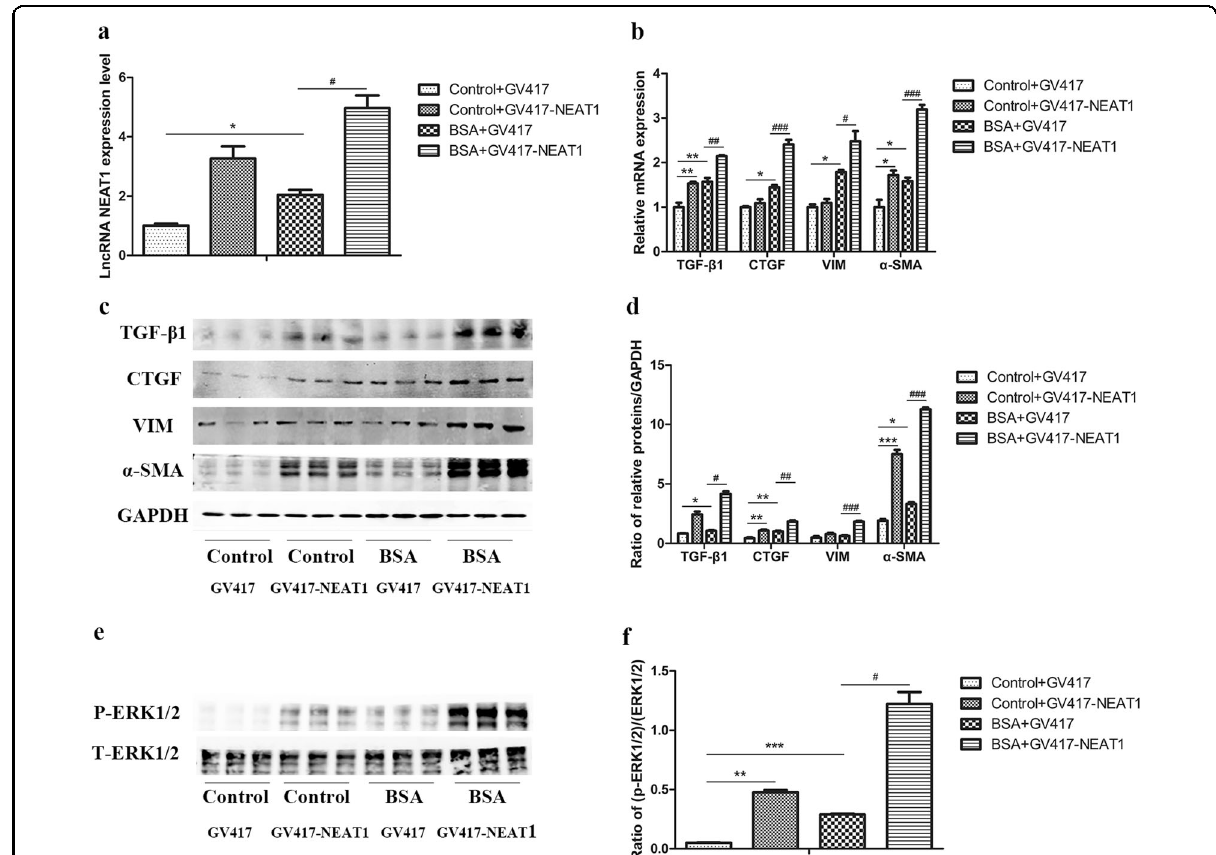
Fig. 5 Overexpression of NEAT1 further increased the expression of fi brosis factors and EMT markers in BSA-induced HK-2 cells. a , b lncRNA NEAT1 expression and the mRNA levels of TGF- β 1, CTGF, vimentin, and α -SMA were measured by qRT-PCR. c , d The protein levels of TGF- β 1, CTGF, vimentin, and α -SMA were measured by western blots. e , f Expression of total and phosphorylated ERK1/2 protein was detected by western blots. * p < 0.05 vs control + GV417, ** p < 0.01 vs control + GV417, *** p < 0.001 vs control + GV417; # p < 0.05 vs BSA + GV417, ## p < 0.01 vs BSA + GV417, ### p < 0.001 vs BSA +